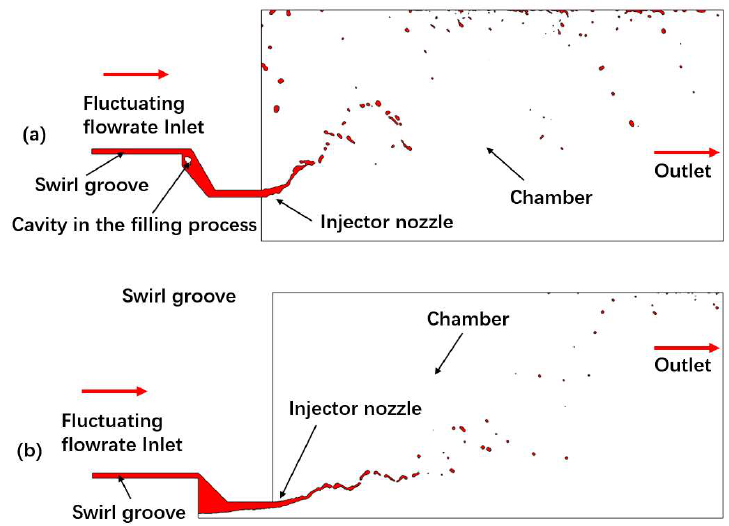
Figure 3. Simulation domains of outer injector spray for NTO and ( a ) and inner injector spray for MMH ( b ). Table 1. Conditions of simulation cases.